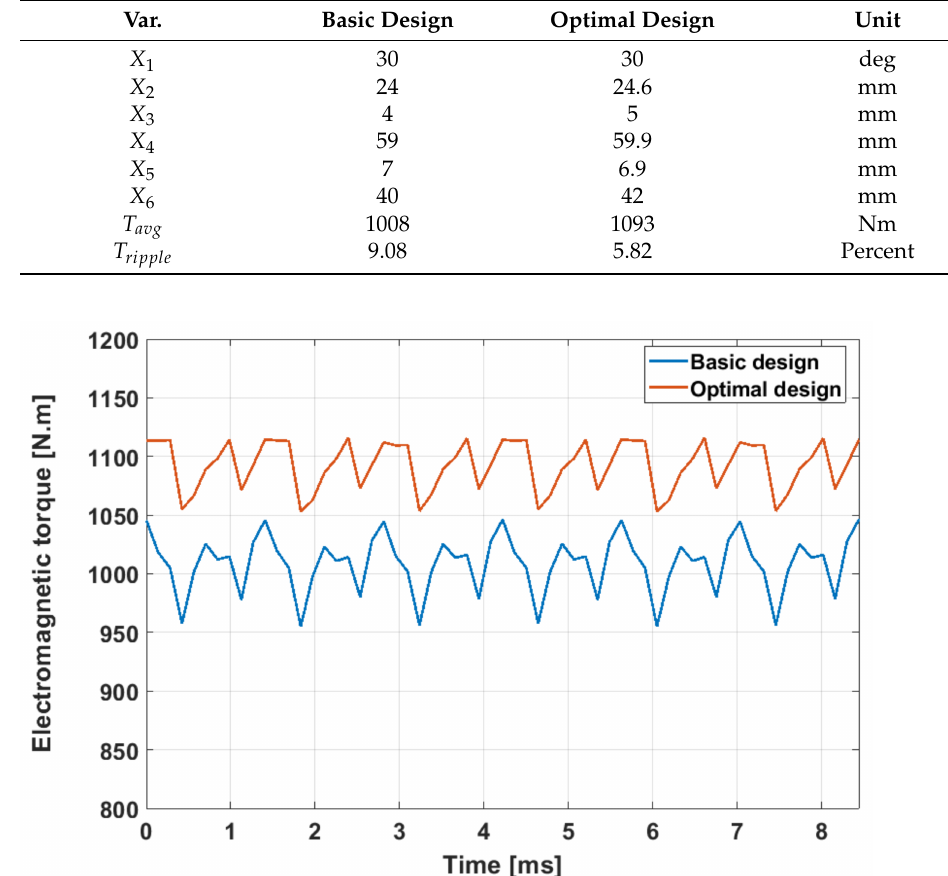
Figure 10. Electromagnetic torque corresponding to the basic design and the optimal design.